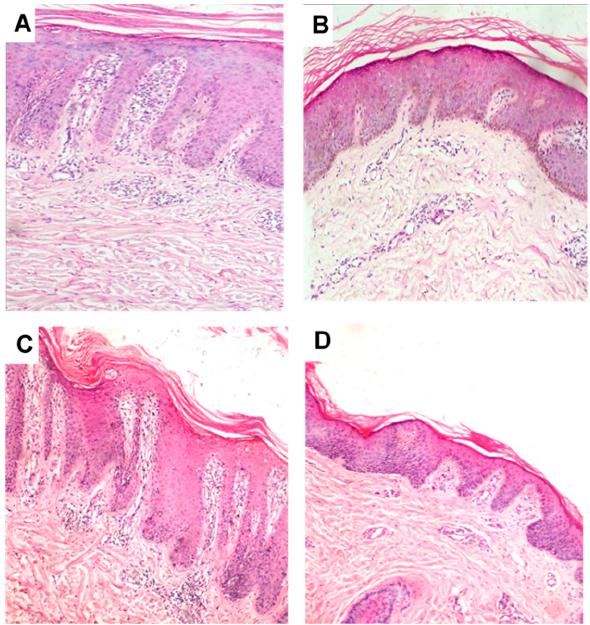
Figure 7. Histopathological manifestation of psoriasis vulgaris. ( A ) and ( B ) before and after treatment with anthralin liposomal gel preparation, respectively (Group I). ( C ) and ( D ) before and after treatment with anthralin ethosomal gel preparation, respectively (Group II). Magnification (10 × , hematoxylin and eosin stain).